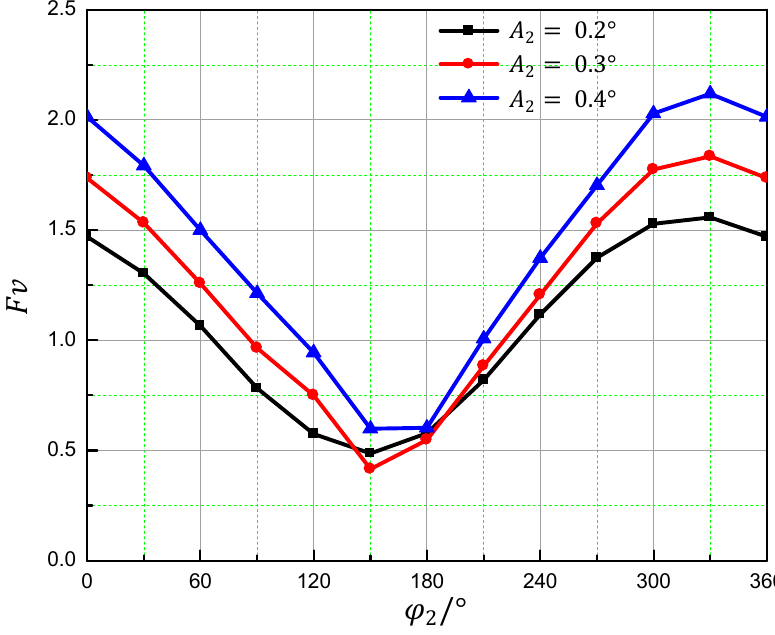
Figure 7. The influence of the phase of second order harmonicon vibration loads.